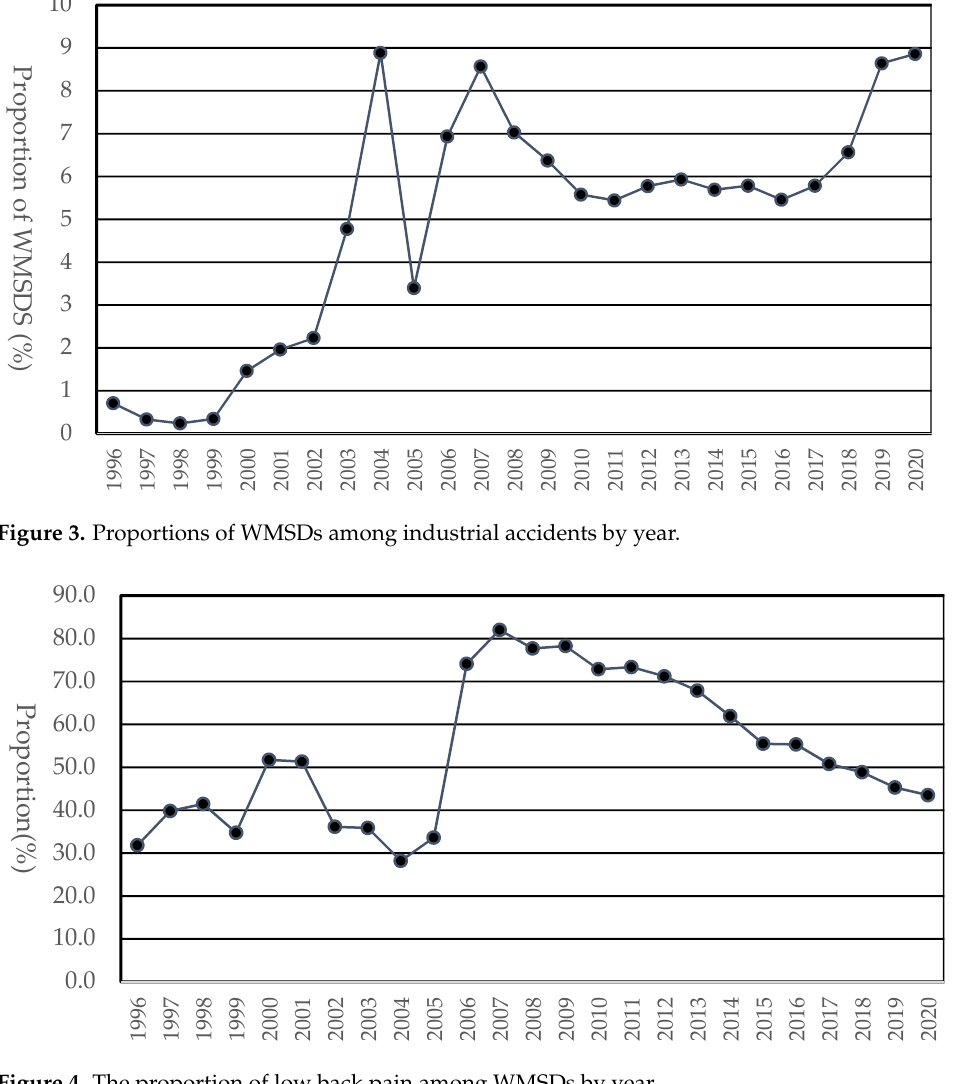
Figure 4. The proportion of low back pain among WMSDs by year.